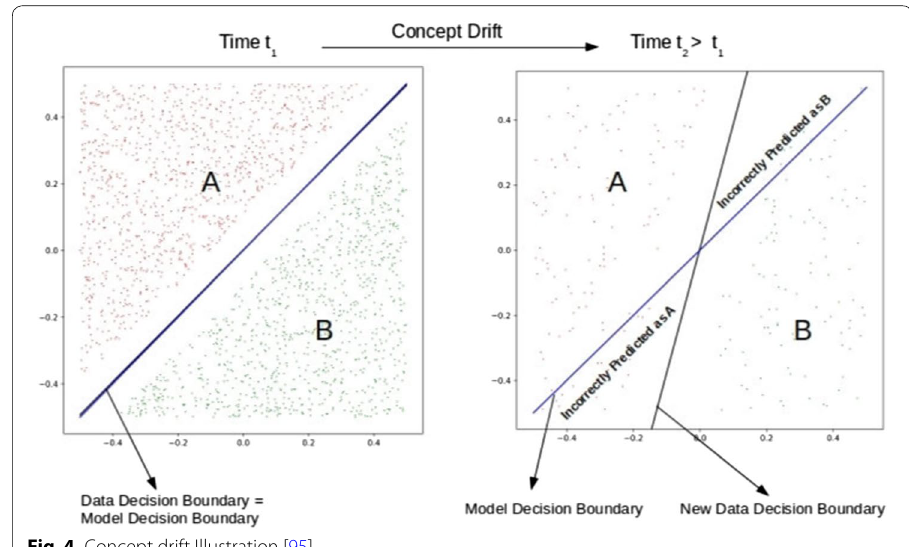
Fig. 4 Concept drift Illustration